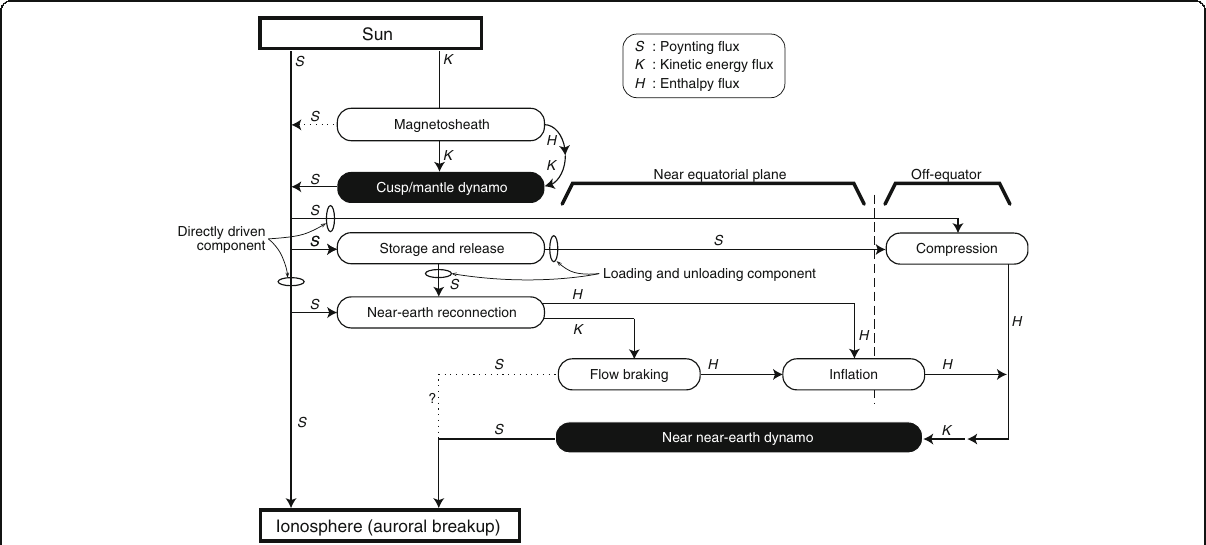
Fig. 16 Possible energy conversion from the Sun to the ionosphere at the expansion onset. S , K , and H represent the Poynting flux, the bulk kinetic energy flux, and the enthalpy flux, respectively. The filled blocks indicate the cusp/mantle dynamo (Tanaka 2000a) and the near-Earth dynamo (Tanaka 2015, Ebihara and Tanaka